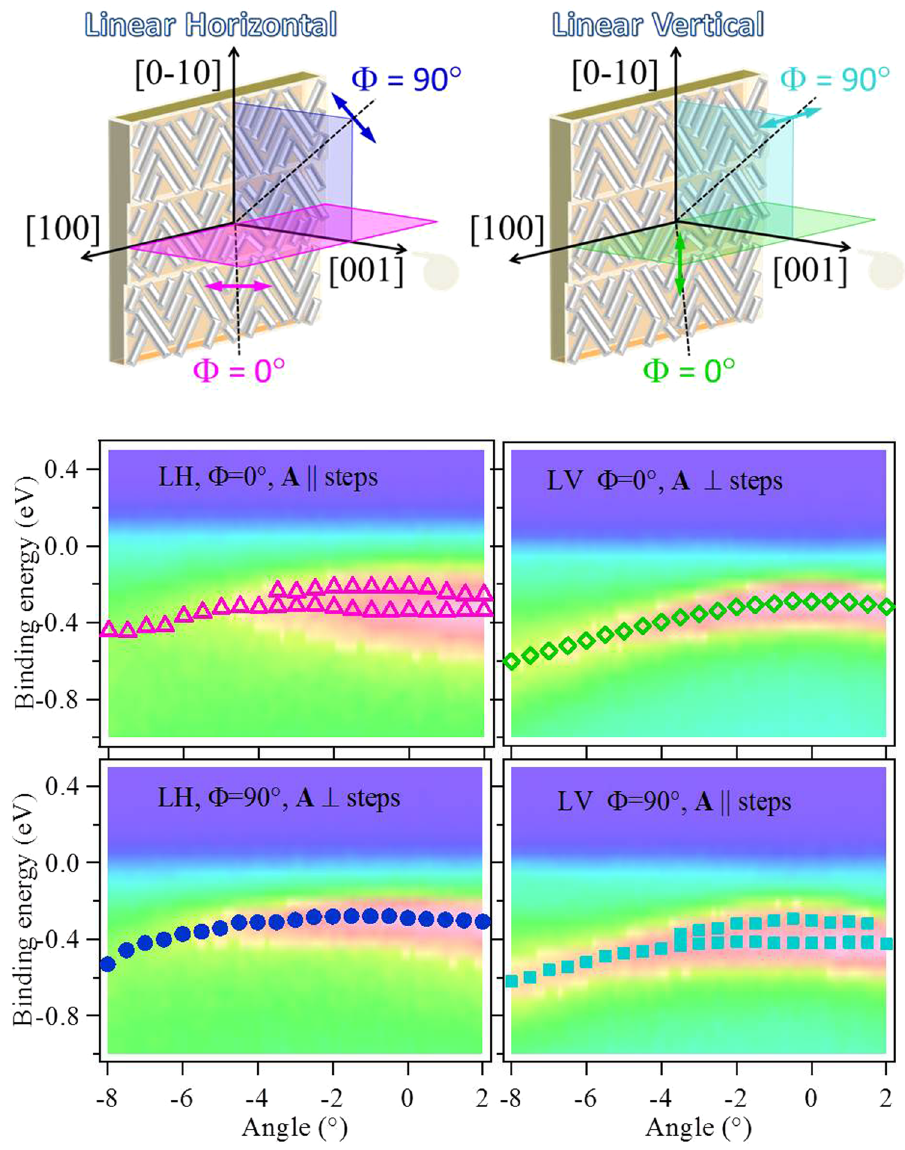
Figure 3. (Top panel) Geometrical configurations used in the experiment. (Bottom panel) ARPES intensity maps measured along the [1 0 0] and [0 − 1 0] directions for LH and LV polarizations. The symbols on the images correspond to the intensity maxima measured for each angle and correspond to the energy dispersion of the states. Two geometries were realized: Φ = (0° ≡ 180°) and Φ = (90° ≡ 270°). For equivalent geometries only tiny differences in intensity are